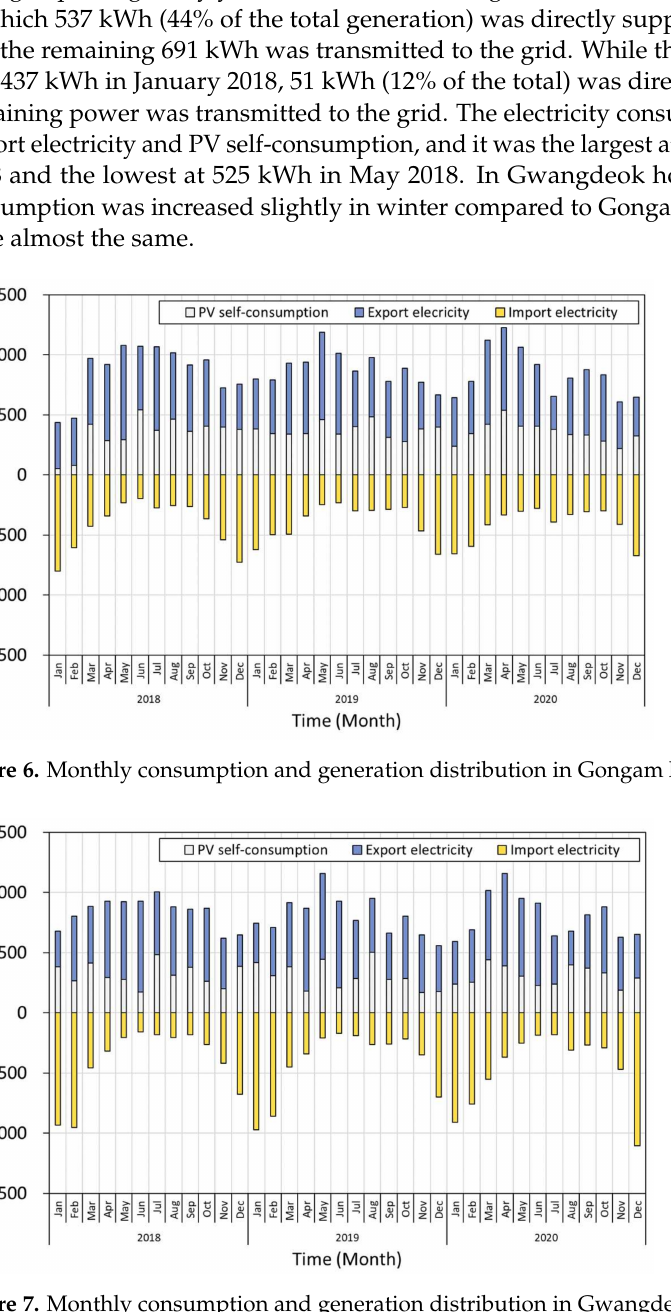
Figure 7. Monthly consumption and generation distribution in Gwangdeok